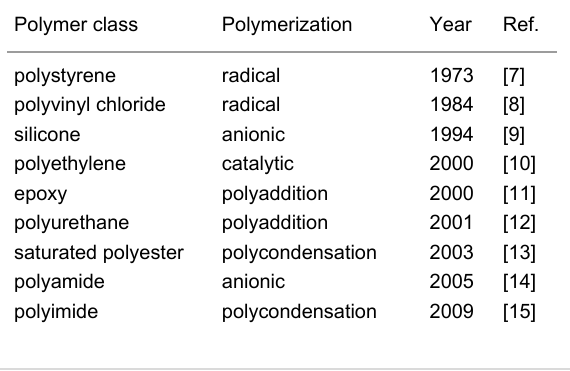
Table 1: Important polymer classes produced by miniemulsion poly- merization.